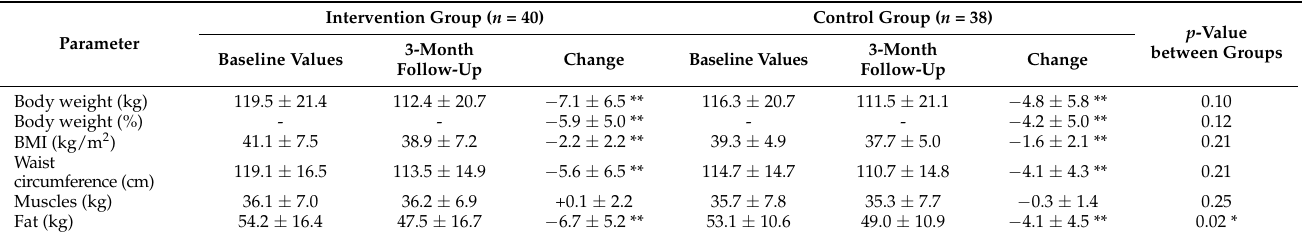
Table 4. Change in anthropometric parameters in 3-month complete